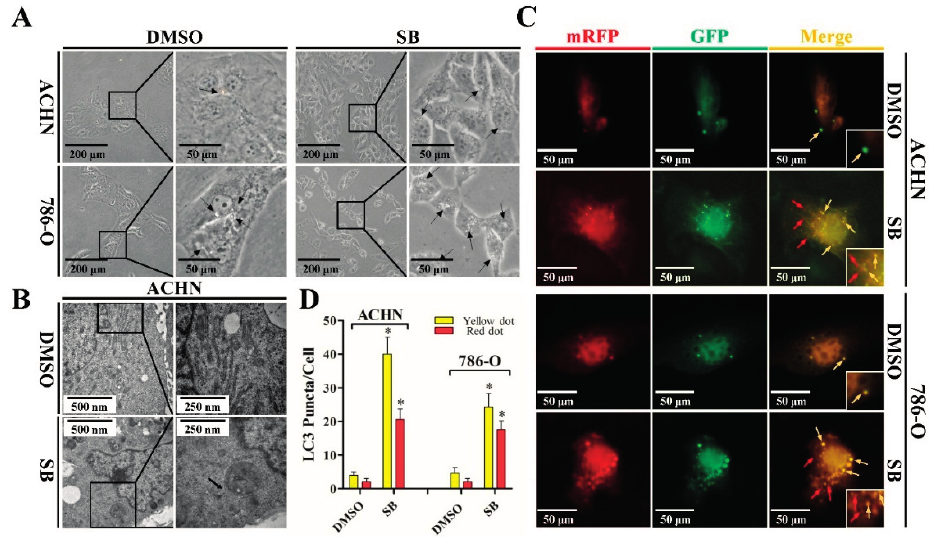
Figure 1. Silibinin induces autophagic vacuoles in RCC ACHN and 786-O cell lines. ( A ) Morphological changes of RCC ACHN and 786-O cells after treatment with 50 μ M silibinin (SB) as indicated for 24 h by inverted phase contrast microscopy (×40 and ×100). The regions indicated by rectangles are shown with higher magnification. Arrows point to cytoplasmic vacuole accumulation; ( B ) Representative electron micrographs of cells treated with 50 μ M silibinin for 24 h (×20,000 and ×40,000). Arrows point to distinct autophagic structures; ( C ) Examples of cells transiently transfected with ptfLC3 plasmid and treated with 50 μ M silibinin for 24 h under fluorescence microscope (×200). Yellow arrows point to autophagosomes and red arrows point to autolysosomes; and ( D ) Quantification of the number of autophagosomes (yellow LC3 puncta) and autolysosomes (red LC3 puncta) per cell. Error bars represent SDs. * p <